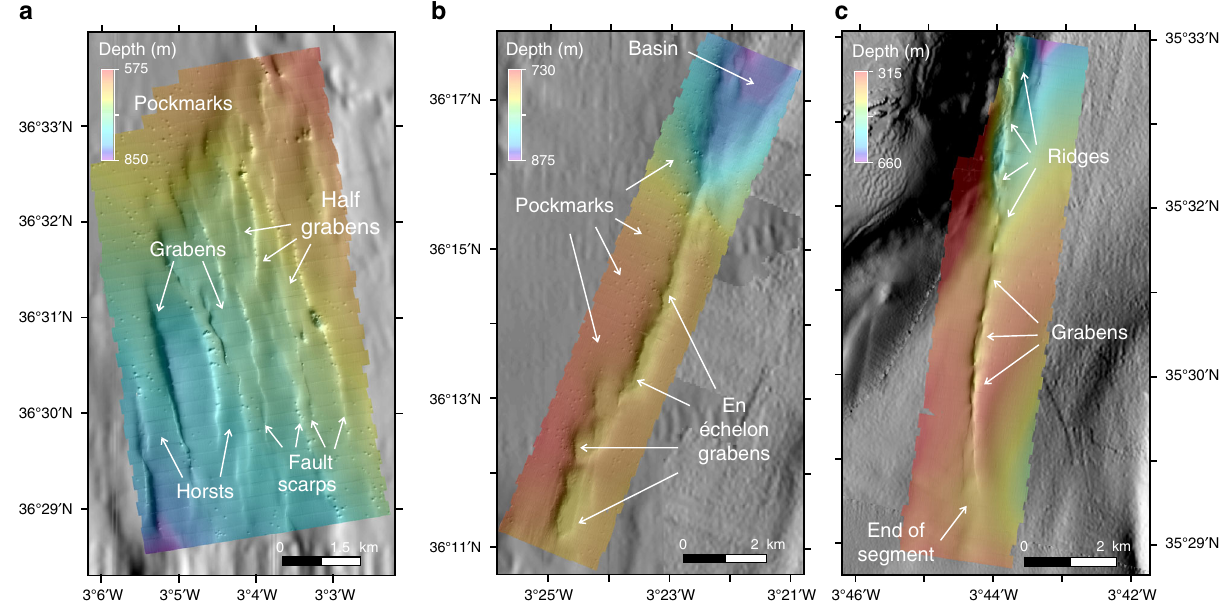
Fig. 3 AUV near-bottom bathymetries. They are gridded at 1-m resolution corresponding to the NS faults ( a ), the North AIFS ( b ) and the South AIFS ( c ) segments. AUV bathymetric maps were acquired using the Autonomous Underwater Vehicles (AUVs) IdefX and AsterX